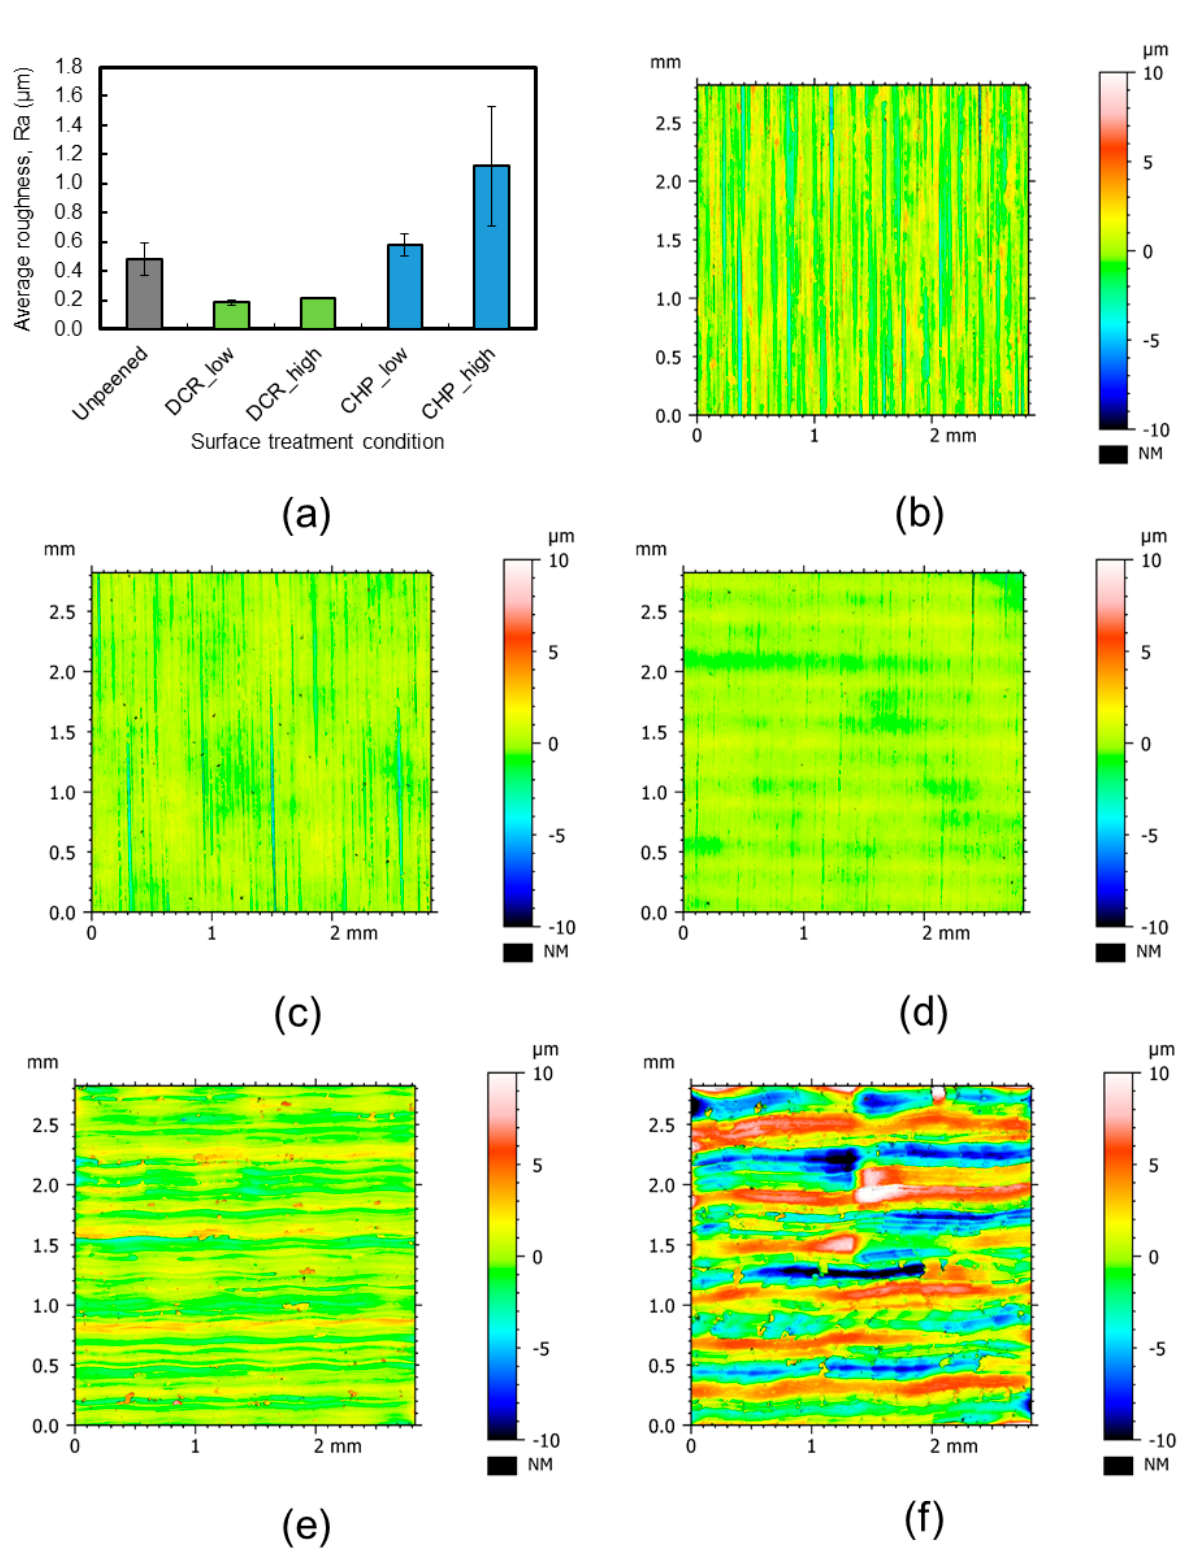
Figure 6. Surface maps under different conditions: ( a ) comparison of average roughness; ( b ) machined surface; ( c ) DCR at low pressure; ( d ) DCR at high pressure; ( e ) CHP under a low processing condition; ( f ) CHP under a high processing condition.